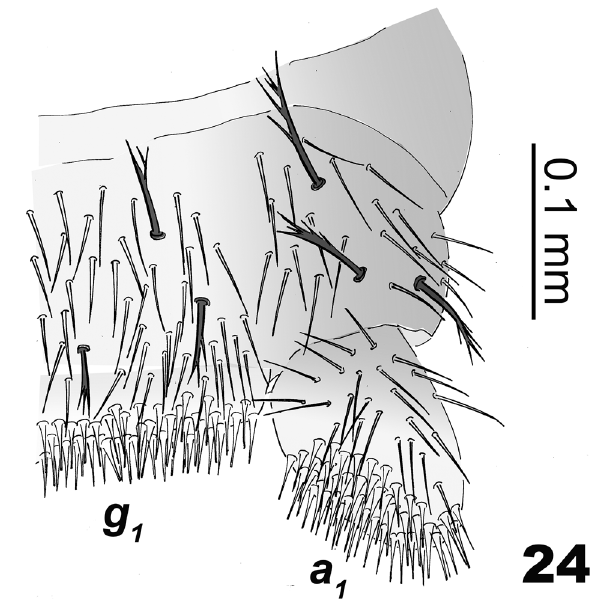
Figure 24. Haplocampa wagnelli Sendra, sp. n. First male urosternite, ♂ paratype, 4.4